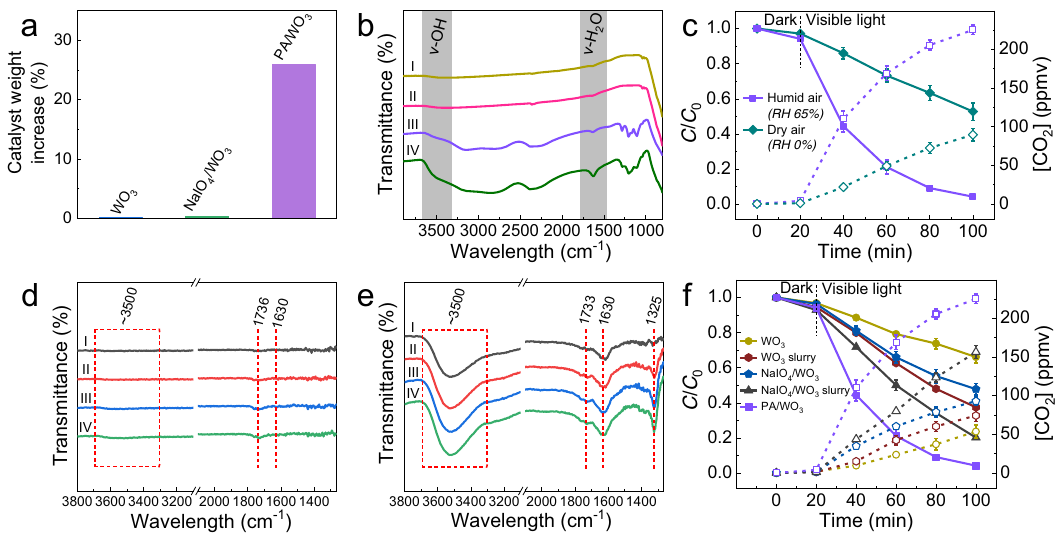
Fig. 3 Formation and effects of the in situ formed water layer. a Catalyst weight increase of PA/WO 3 , NaIO 4 /WO 3 , and bare WO 3 samples after exposing each catalyst under humid air (RH 65%) for 30 min. RH is de fi ned as relative humidity. b FT-IR spectra of bare WO 3 (I) before and (II) after exposure to humid air, and those of PA/WO 3 (III) before and (IV) after exposure to humid air for 30 min. c PCD activity of PA/WO 3 for acetaldehyde (AA) degradation after exposure to dry and humid air for 30 min. In situ DRIFT spectra for d PA/WO 3 after exposing the sample to 300 ppmv AA/dry air stream and e PA/WO 3 in 300 ppmv AA/RH 65% air stream for (I) 10 s, (II) 1 min, (III) 3 min, and (IV) 5 min. The spectra of the dry PA/WO 3 surface were collected and used as the background. f PCD activity of bare WO 3 , NaIO 4 /WO 3 , and their slurries containing 26 wt% water for the degradation of AA. The dashed lines with open symbols represent the CO 2 concentration generated from AA degradation. Error bars are de fi ned as standard deviation. Experimental conditions: [AA] 0 = 120 ppmv; visible light ( λ > 420 nm) intensity of 2.2 mW/cm 2 ; sample amount of 50 mg (with 13 mg of extra water in the case of WO 3 slurry and NaIO 4 /WO 3 slurry); reaction temperature of 30